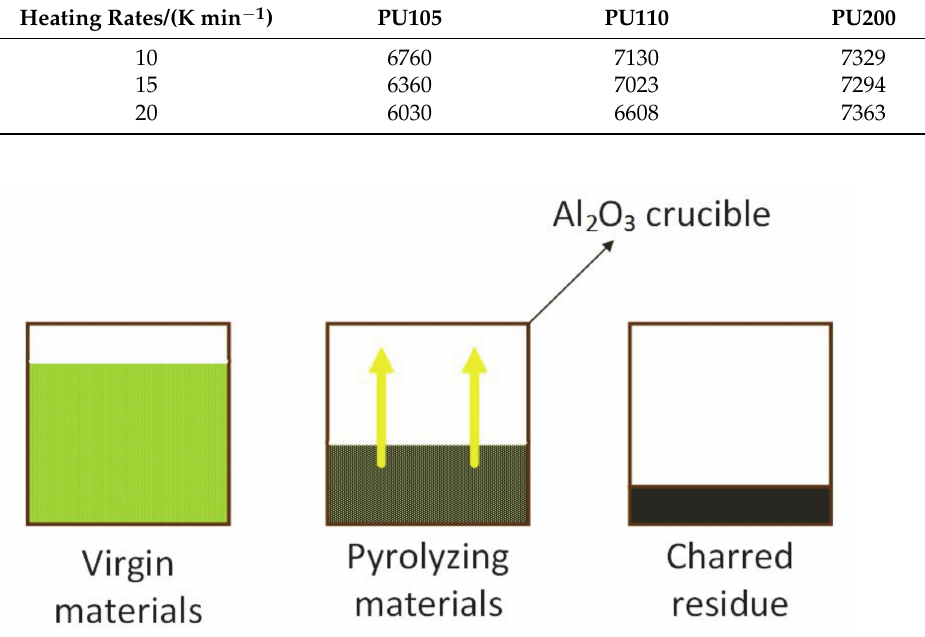
Figure 6. DSC testing process of polyurethane with charring volume